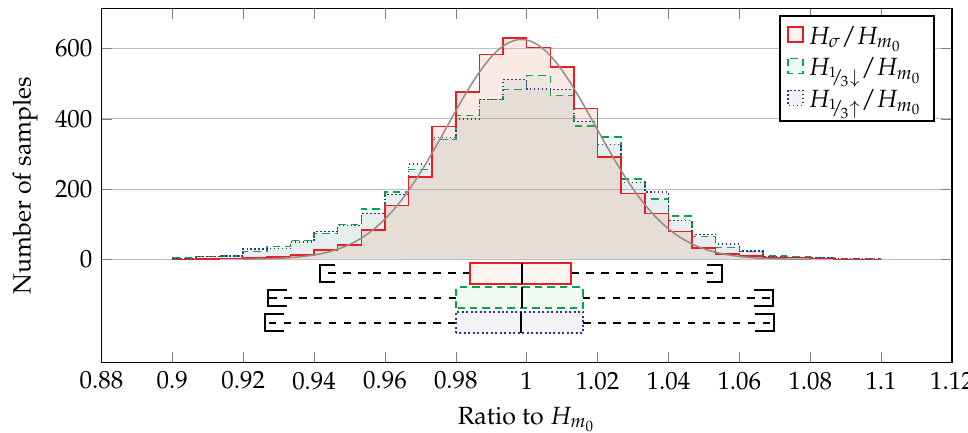
Figure 3. Histogram and box plot of the ratio between H σ , H 1 / the 5000 sampled